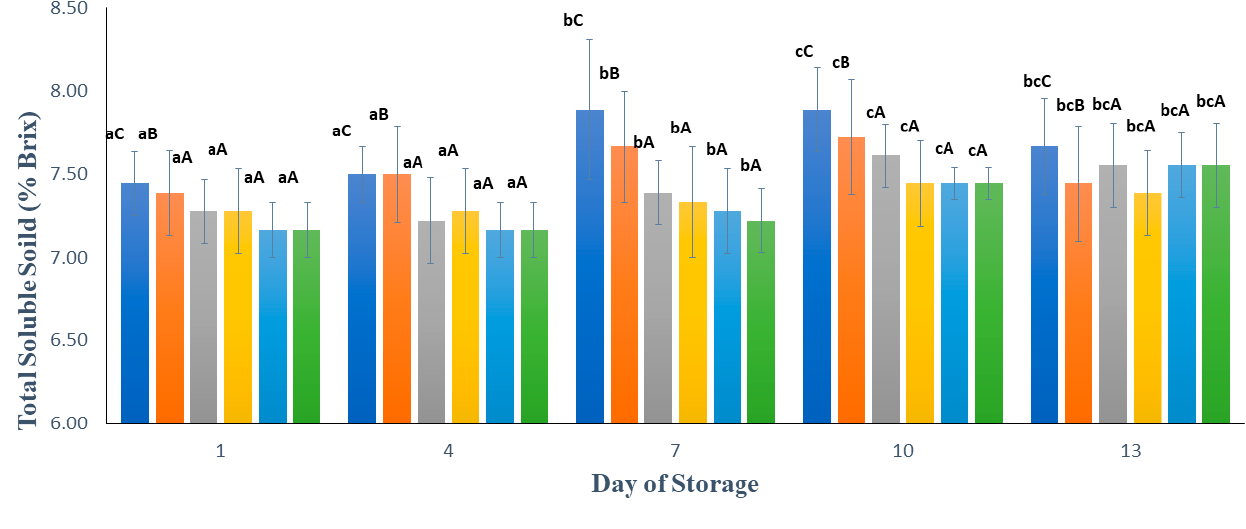
Figure 8. Effect of edible coating of gelatin composite enriched with black tea extract on total soluble solids (% Brix) of minimally processed watermelon during storage. The value shown is the average of the three experimental replications. A–C Values followed by the same capital letters showed no significant difference ( p > 0.05) between treatments on the same day. a–c Values followed by the same non-capital letters showed no significant difference ( p > 0.05) between storage times in the same treatment.